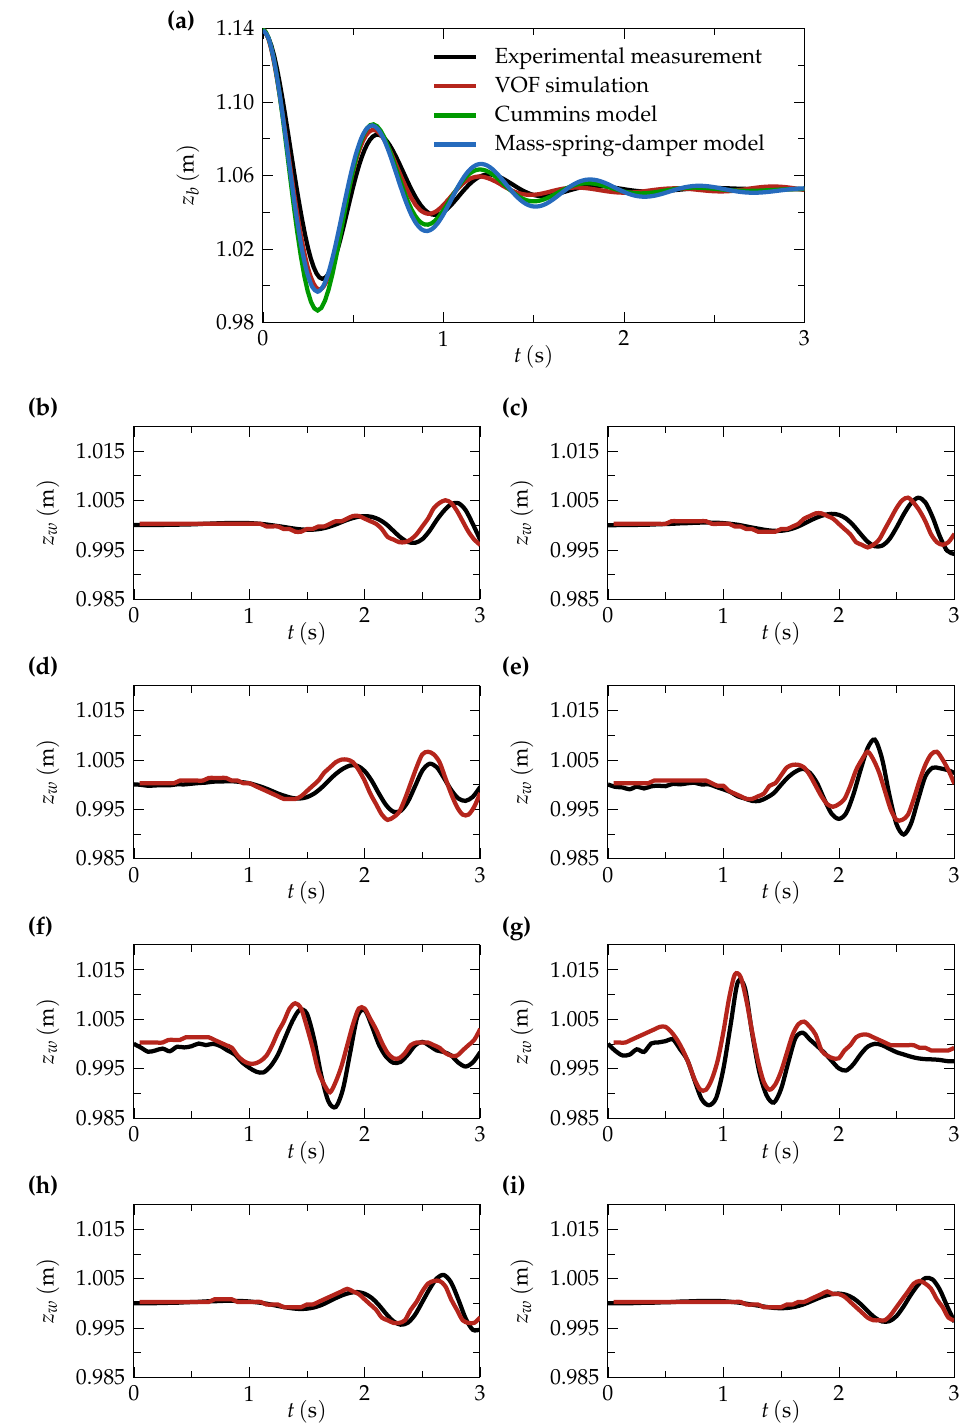
Figure 5. ( a ) Comparison between experimental measurement and three types of numerical calcula- tions for the time evolution of the vertical position of the buoy. ( b ) Comparison between experimental measurements and VOF calculations for the time history of the vertical position of the air–water interface at eight locations near the buoy. Experimental data represent averages over ten realizations, where the coefficient of variation (the ratio of the standard deviation to the mean) for the vast majority of the collected data was below a few percentage points. Subfigures ( b – i ) correspond to wave gauges 1–8 (see Figure 2a,b). The mean absolute differences between the plots presented here are reported